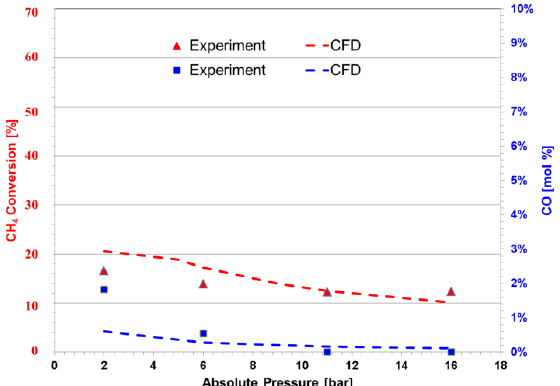
Figure 6. Experimental and computational simulation of two catalysts in a PBR as a function of different